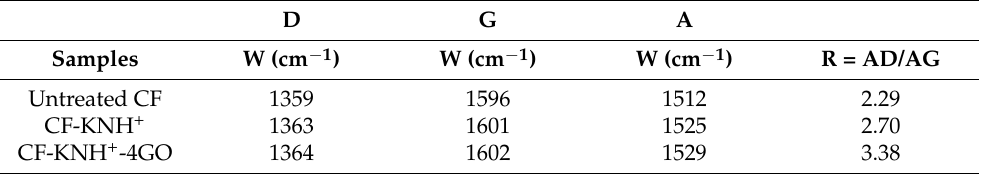
Figure 4. Raman spectra of carbon fiber ( a ) Untreated CF, ( b ) CF-KHN + , ( c ) CF-KHN + -4GO. Table 1. Wavenumbers of D, G and A bands and the calculated values of “AD/AG” acquired from carbon fibers.